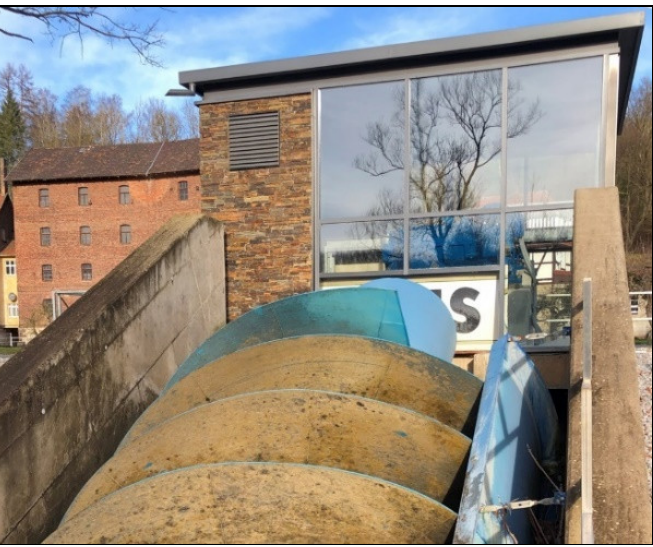
Figure 23. Hydraulic screw installed on the premises of a brewery in central Germany (photo by J. Dietrich).